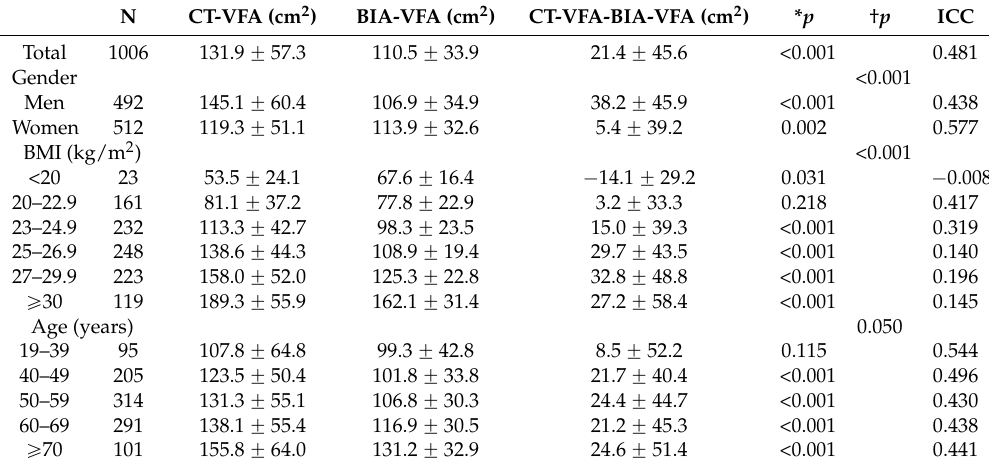
Figure 1. Correlation between VFA measured by CT and VFA estimated by BIA ( A ) and Bland-Altman plot for comparing the two methods ( B ). Table 2. Mean differences of VFAs observed by CT and BIA according to the gender, body mass index, and age